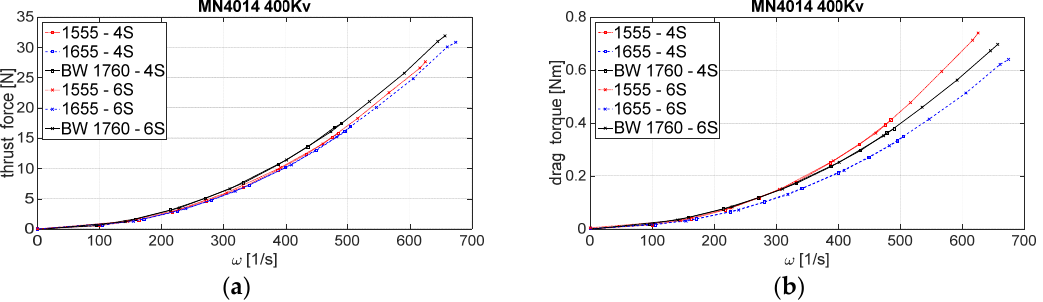
Figure 18. Aerodynamic effects with respect to rotor angular velocity, MN 4014 BLDC motor: ( a ) thrust force; ( b ) drag torque.